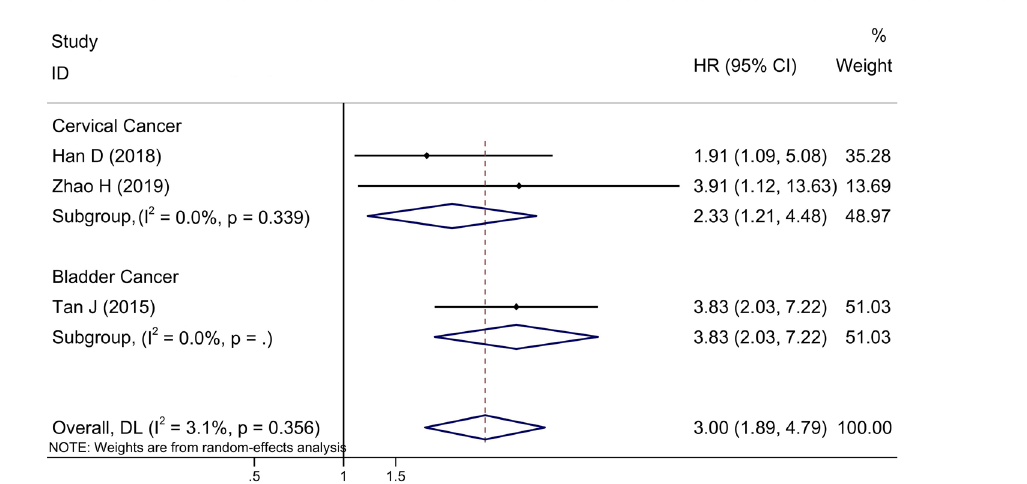
Figure 3. Forest plot for the association between lncRNA expression levels and OS. OS overall survival, HR hazard ratio, CI confidence interval.